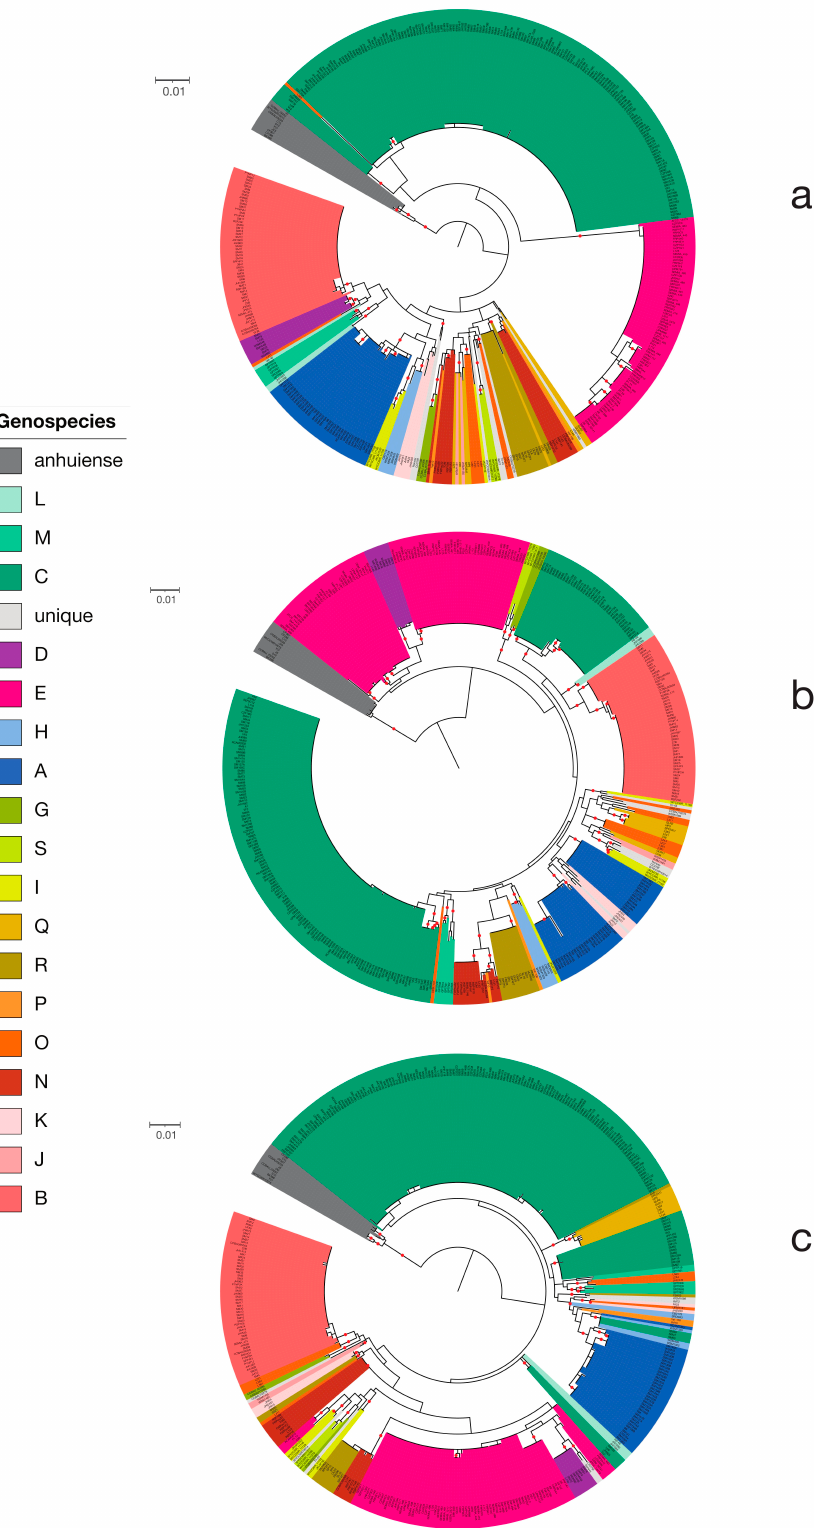
Figure 6. Phylogenies of individual housekeeping gene amplicons. ( a ) atpD . ( b ) gyrB . ( c ) recA . Colors indicate genospecies. Red dots indicate bootstrap support >70%. Scale bars indicate 1% sequence divergence. Interactive versions are available at